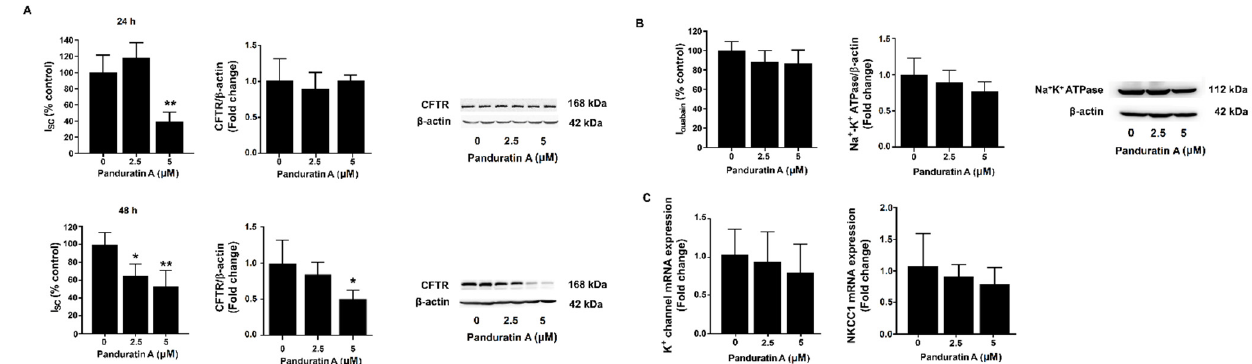
Figure 3. Effect of panduratin A on function and expression of ion transporters. ( A ) CFTR-mediated Cl - secretion ( n = 10) and CFTR protein expression ( n = 4–5). ( B ) Na + –K + ATPase activity ( n = 3) and protein expression ( n = 5), and ( C ) K + channel and NKCC1 mRNA expression ( n = 3). MDCK cell monolayers were incubated with panduratin A at indicated concentrations for 24 h or 48 h. Data are presented as mean of percentage control ± SD; * p < 0.05, ** p < 0.01 compared to